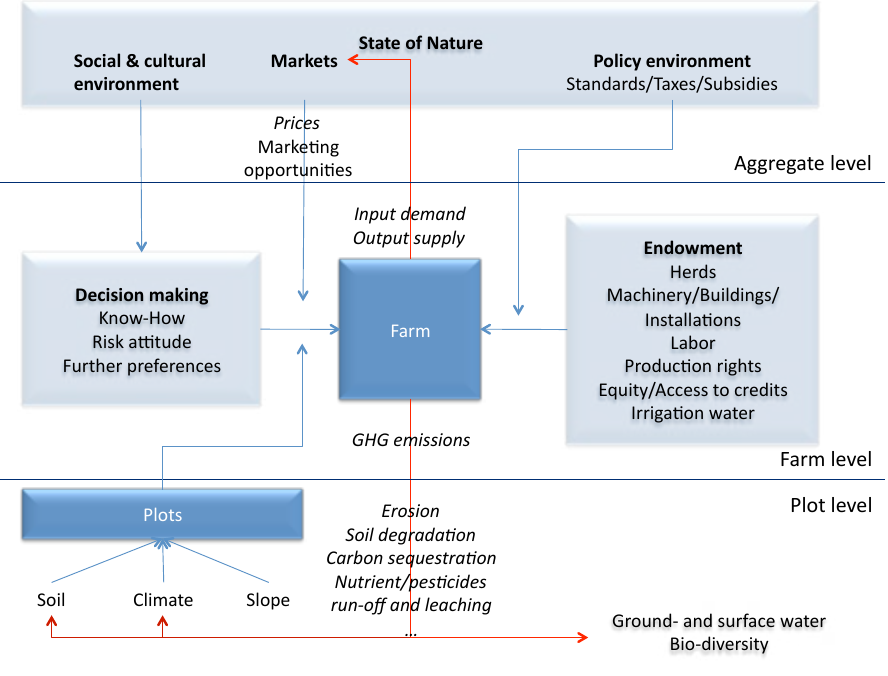
Figure 1. Overview of IA